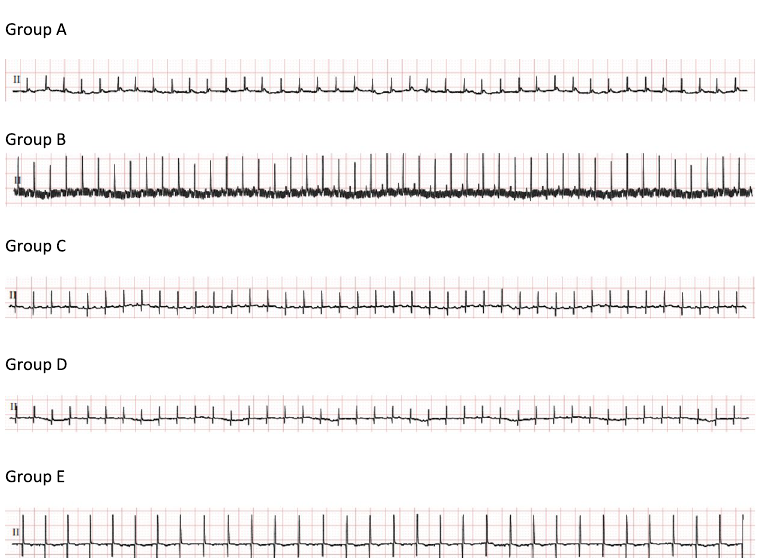
Figure 4. Effect of pretreatment of CurNisNp on ECG pattern in MI induced guinea